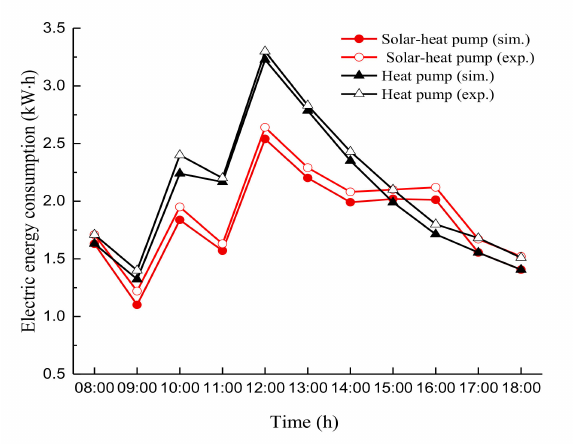
Figure 11. Comparison of the measured and the simulated electric energy consumption.